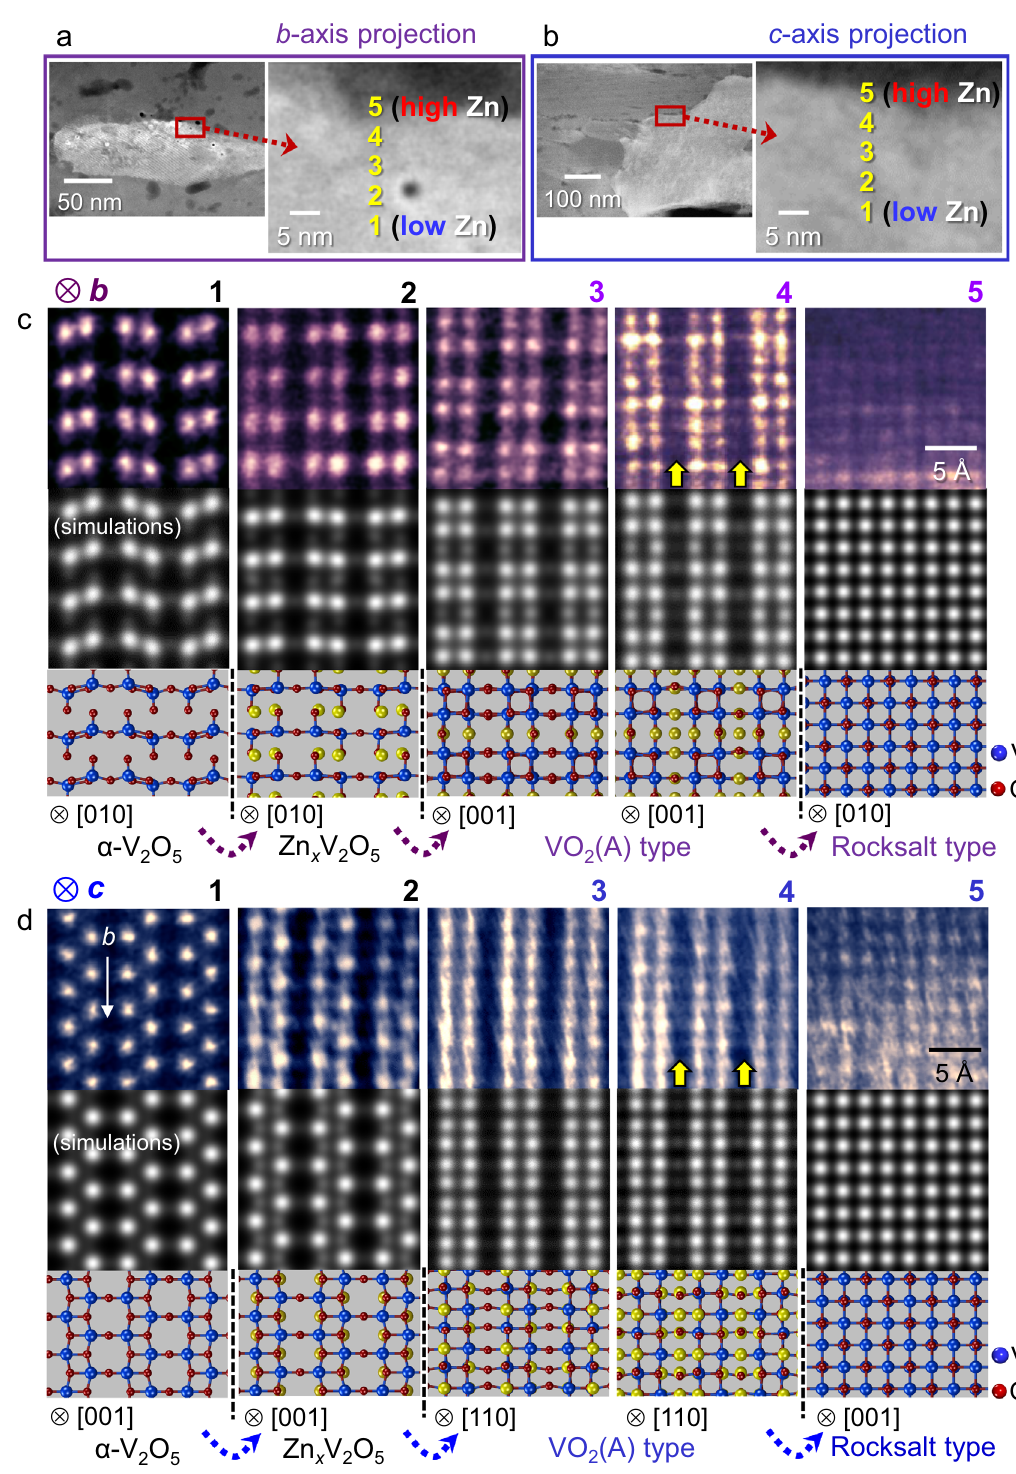
Fig. 5 Topotactic multiphase transformations. a , b This sample was discharged to 0.77 V. Boundary regions of grains in both b - and c -axis projections were observed, as denoted by a red rectangle in each projection. A larger amount of Zn is detected when the location for observation approaches the grain- boundary. c , d Magni fi ed ADF images from locations 1 − 5 and corresponding simulated images are provided in each projection together with schematic illustrations of the atom positions. Yellow arrows indicate the sites showing a detectable intensity by Zn minimum 54 in the overall energy landscape during the trans- formation of V 2 O 5 , even though the intercalation site of Zn is distinct. A wider view of the rocksalt phase is provided in Supplementary Fig. 20.